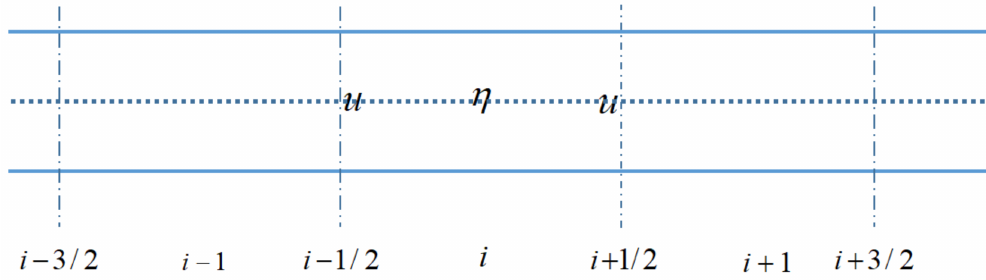
Figure 1. The control volume and grid used in the hydrodynamic